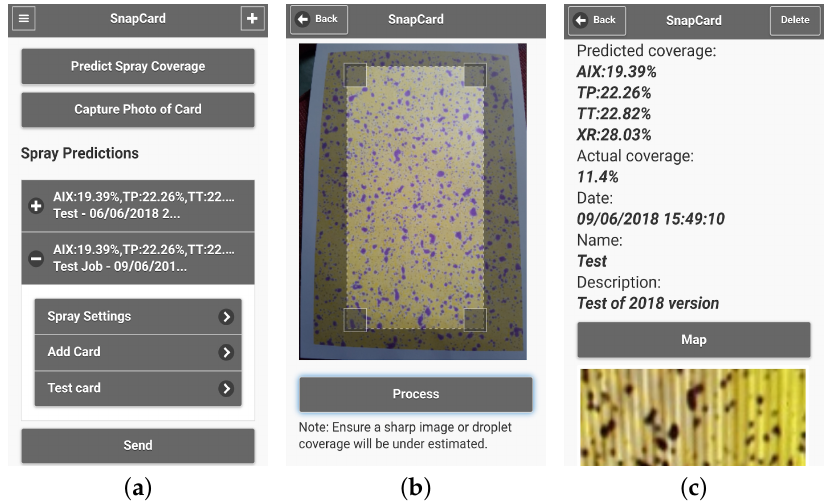
Figure 14. SnapCard: ( a ) Main menu; ( b ) Cropping tool where a scanned card is adjusted to area of interest for analysis; ( c ) Measured spray cover